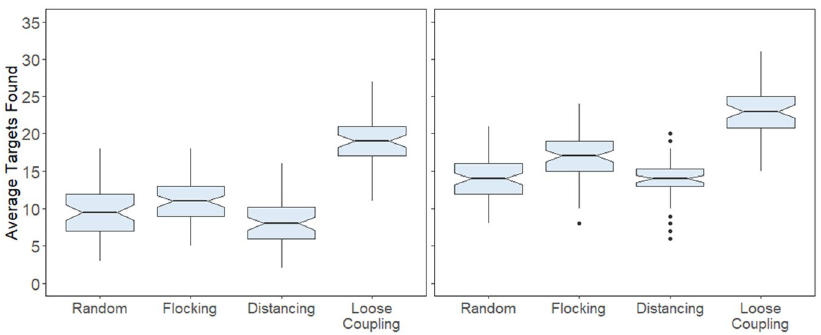
Figure 4. Mean targets found per session as a function of movement type without human intervention (left) and with human intervention